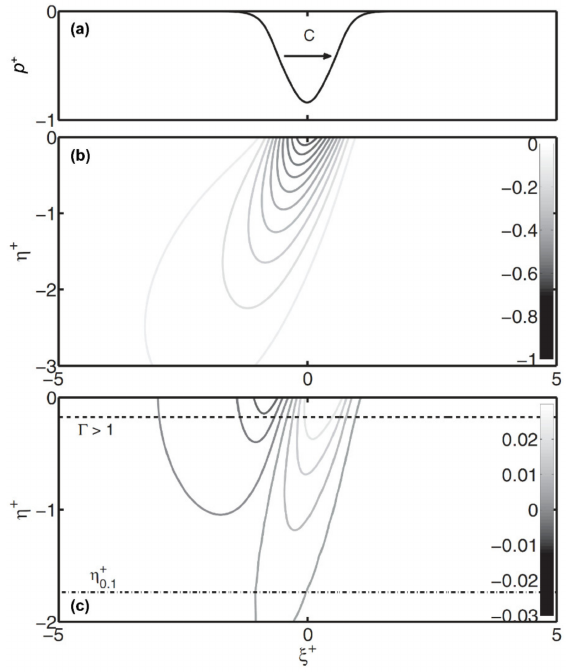
Figure 9. Contour of the pore-pressure changes by ISWs. The ISW traveling to the right with phase speed c , where ( a ) is the ISW-induced pressure forcing and ( b ) is the pore-pressure changes for an unsaturated seabed composed of medium sand. ( c ) Vertical pore-pressure gradient with an unsaturation seabed composed of medium silt. The dashed-dot line marked as η + penetration depth, where the changes of pore pressure are 10% of the bottom pressure under the wave trough. The dashed line marked as Γ > 1 shows the failure criterion, where the buoyant unit weight of sediment is less than the vertical pore-pressure gradient. Panels ( a – c ) adapted from Rivera-Rosario et al. [21], with permission from